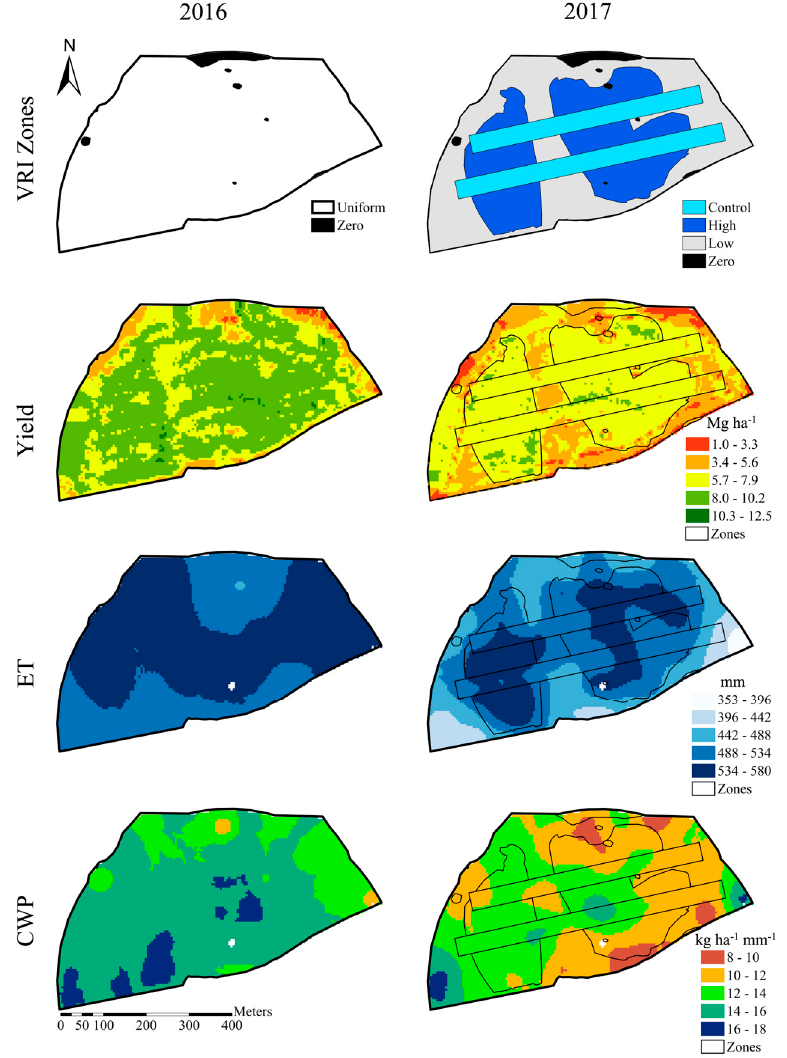
Figure 2. Variable rate irrigation (VRI) zones (first row), spatially variable wheat yield (second row), evapotranspiration (ET) (third row), and crop water productivity (CWP) (fourth row) for 2016 and 2017. These data were used to create the irrigation management zones for 2019.